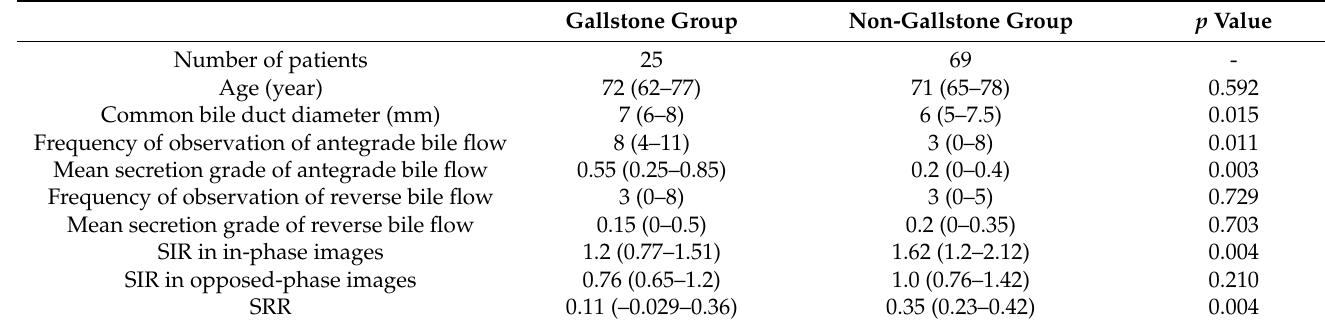
Comparison of the MR measurements between the gallstone group and the non- gallstone group. Gallstone Group Non-Gallstone Group p Value